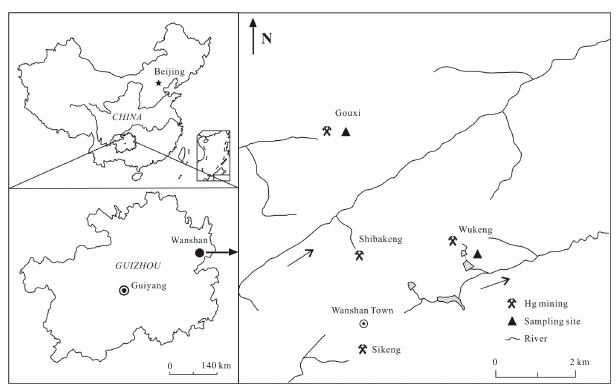
Figure 1. Map of the study area and sampling sites including abandoned Hg mining site (Wukeng) and artisanal Hg mining site